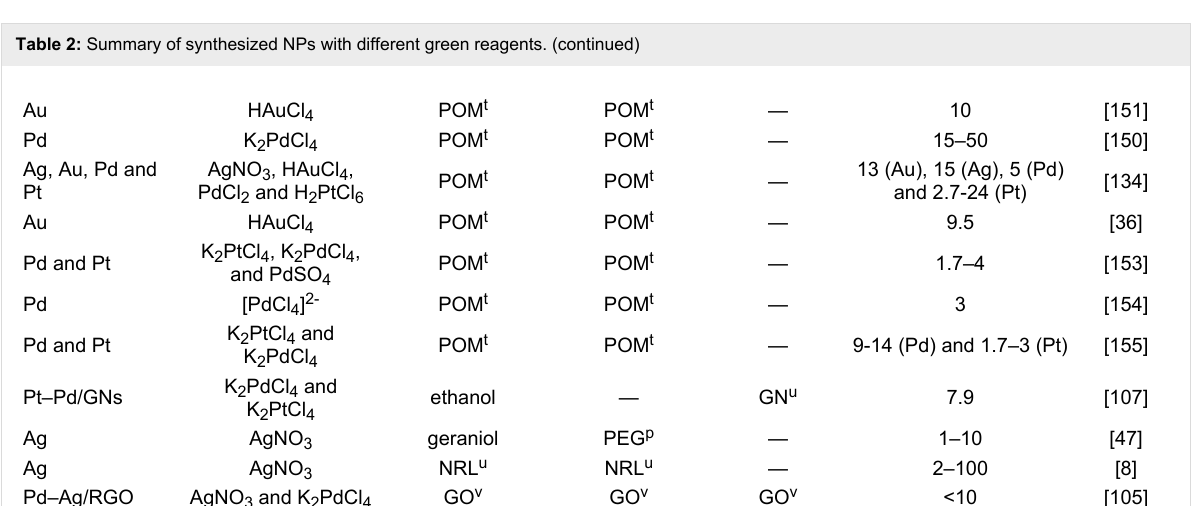
Table 2: Summary of synthesized NPs with different green reagents. (continued)